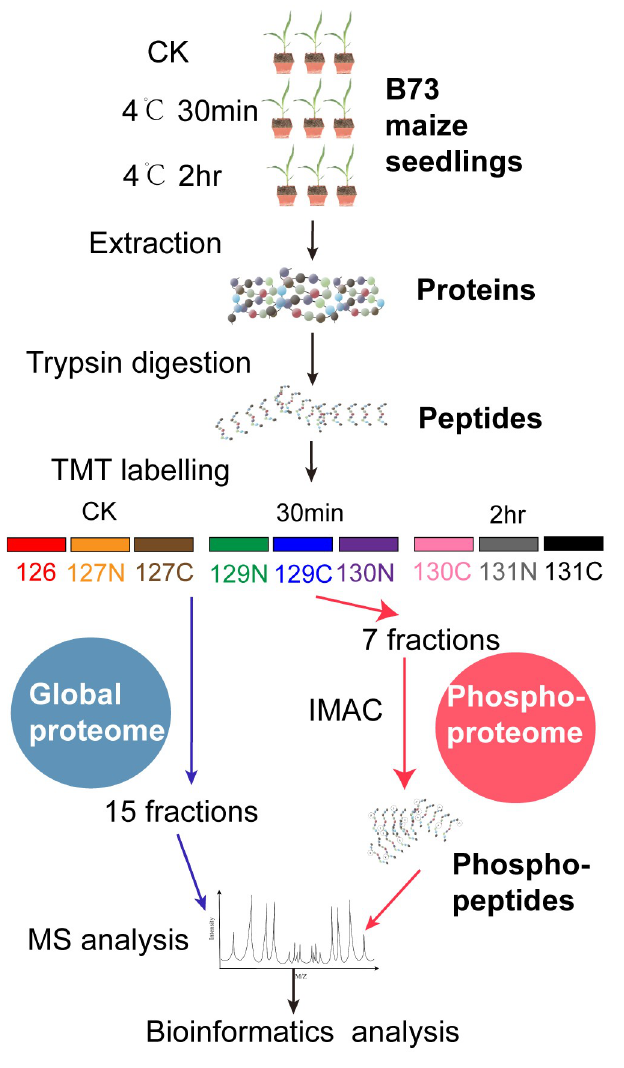
Figure 1. Workflow for global proteome and phosphoproteome profiling of maize seedlings under rapid temperature drop. Five-leaf-stage B73 maize seedlings were cold treated at 4 ◦ C for 30 min and 2 h. Protein samples were labeled with individual TMT reagents, combined, and fractionated into 15 fractions for global proteome analysis or 7 fractions for phosphoproteome